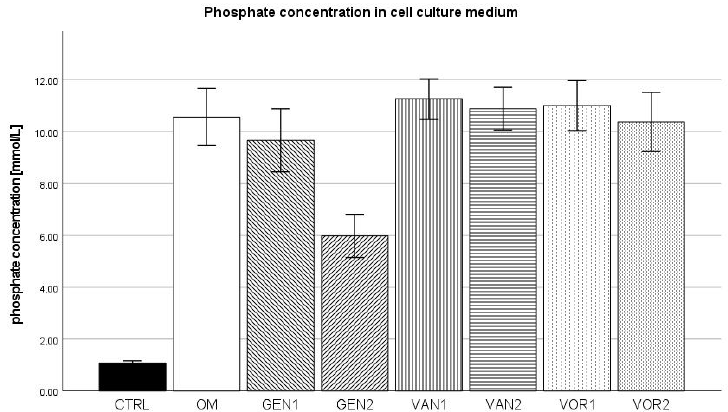
Figure 4. Absolute mean phosphate concentration per group as measured in the cell culture medium. The error bars show the error of mean.